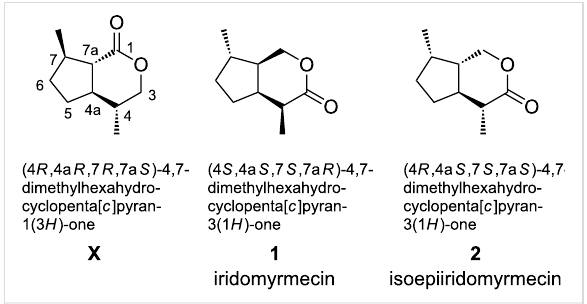
Figure 1: Structures of cis - and trans -fused iridoid lactones.